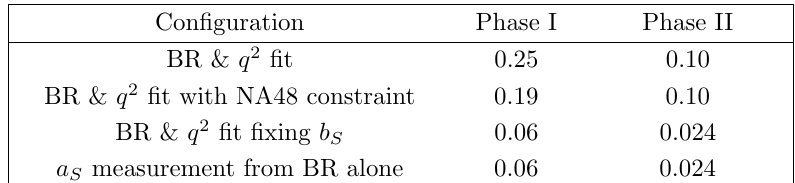
Table 4 . Projected statistical uncertainties on a